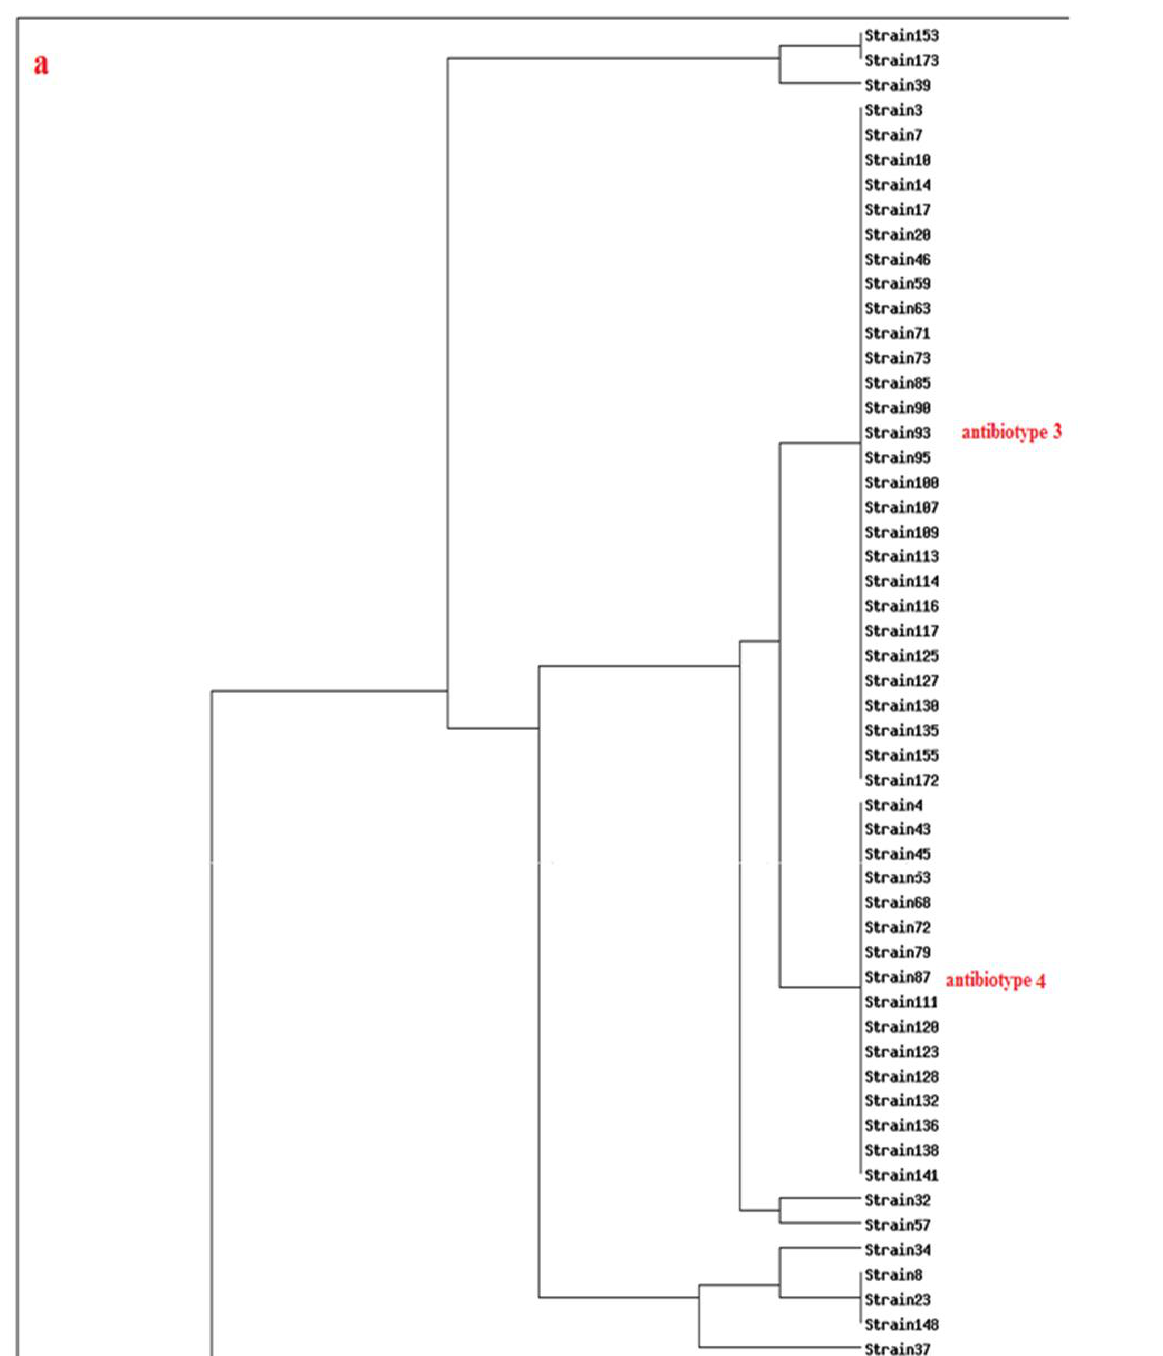
Figure 1(a, b and c). Dendrogram of susceptibility reports of all Bacillus isolates. Cluster analysis was generated with the Dice similarity coefficient and UPGAMA clustering